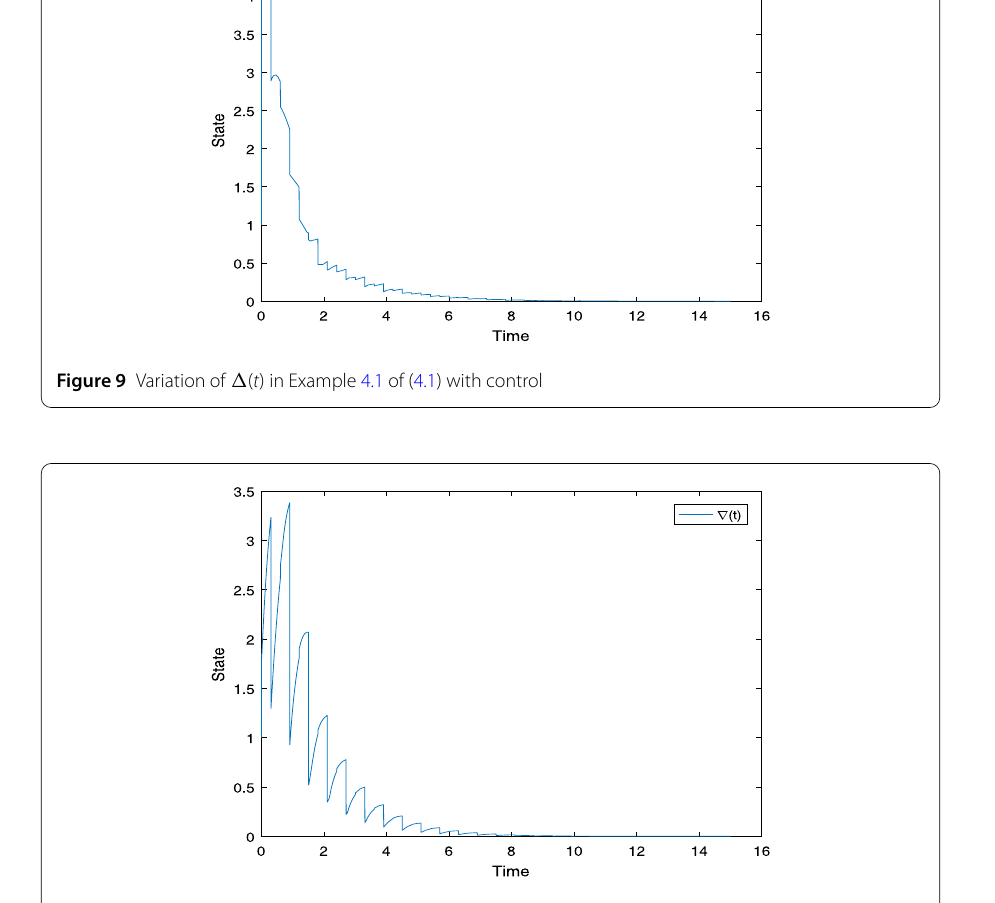
Figure 10 Variation of ∇ ( t ) in Example 4.1 of (4.2) with